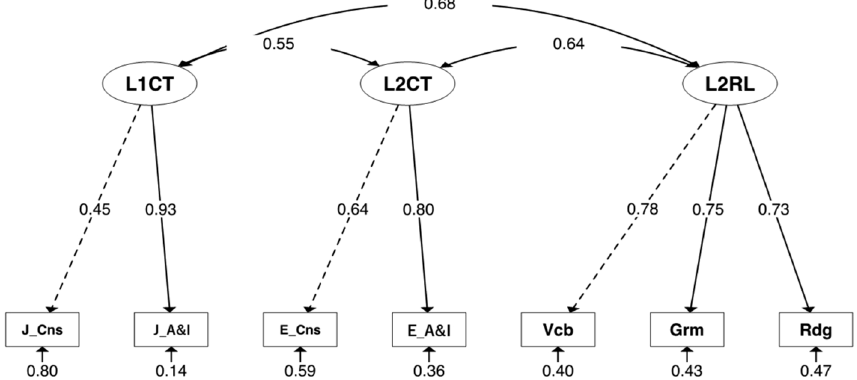
Fig. 4 Three-factor correlated model. Notes. All path coefficients are standardized and significant ( p <.001); L2CT L2 critical thinking; L1CT L1 critical thinking; L2RL = = GFI .98, AGFI .94, SRMR .03, CFI 0.86, RMSEA = = = =